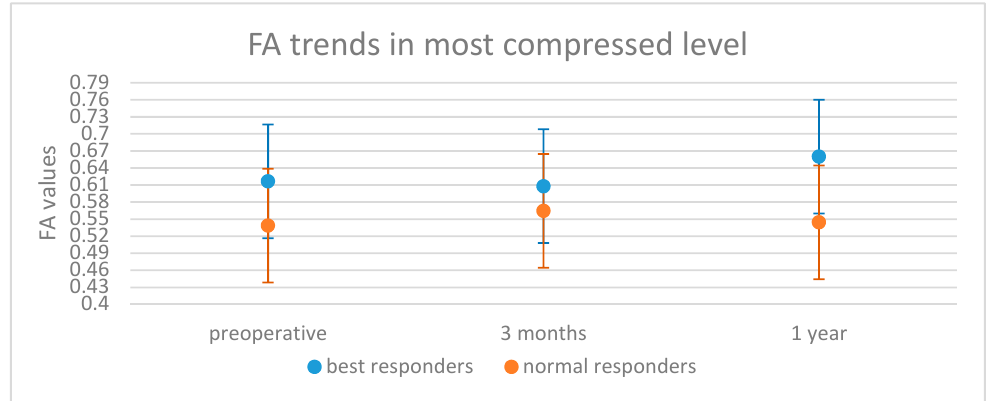
Figure 3. Differences between fractional anisotropy average values of the most compressed level in best responders (blue) and normal responders (red) patients.